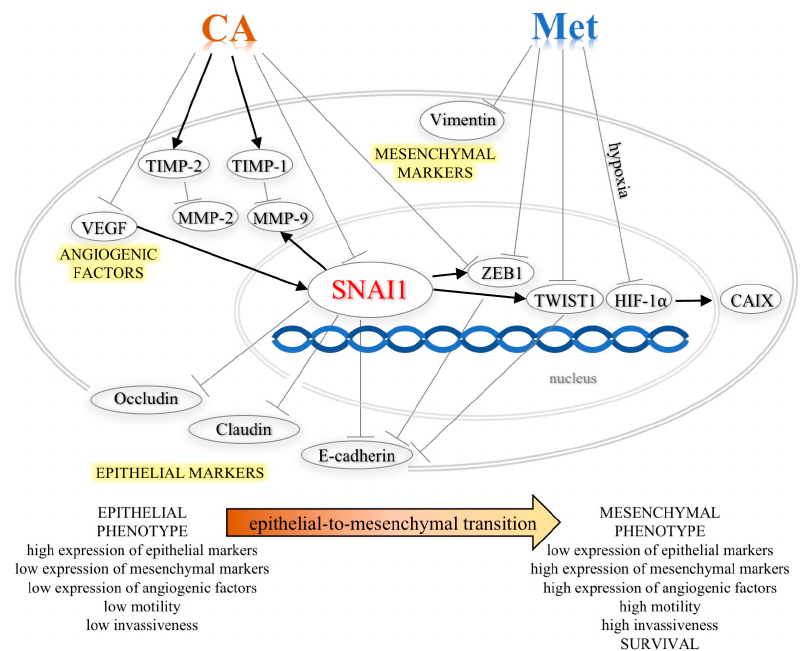
Figure 9. Schematic representation of the roles of CA and Met in inhibition of TGF- β 1-induced EMT phenotype of cervical carcinoma cells. ( ↑ —activation, Ⱶ —inhibition).